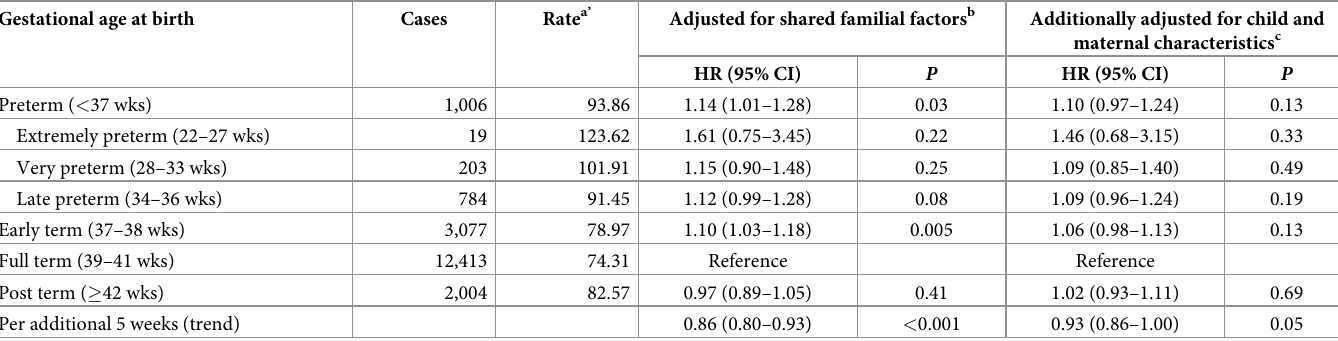
Table 3. Co-sibling analyses for gestational age at birth in relation to risk of lipid disorders, Sweden,